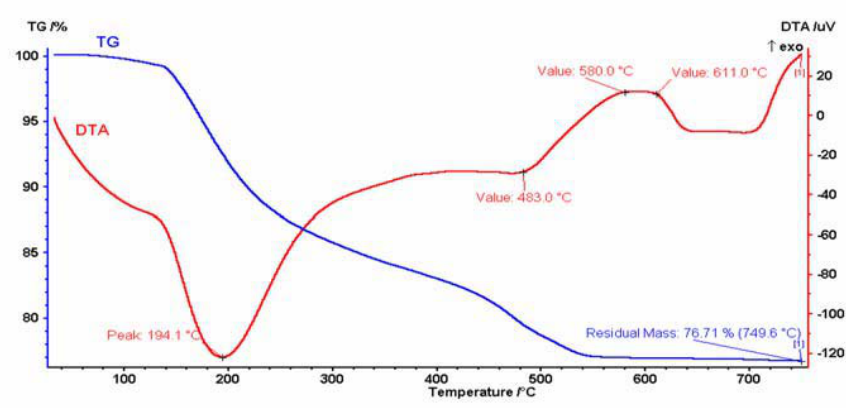
Fig. 1 TG and DTA curves of reaction mixture for Al 0 . 3 La 0 . 7 P 3 O 9 sample (mass: 518 mg).